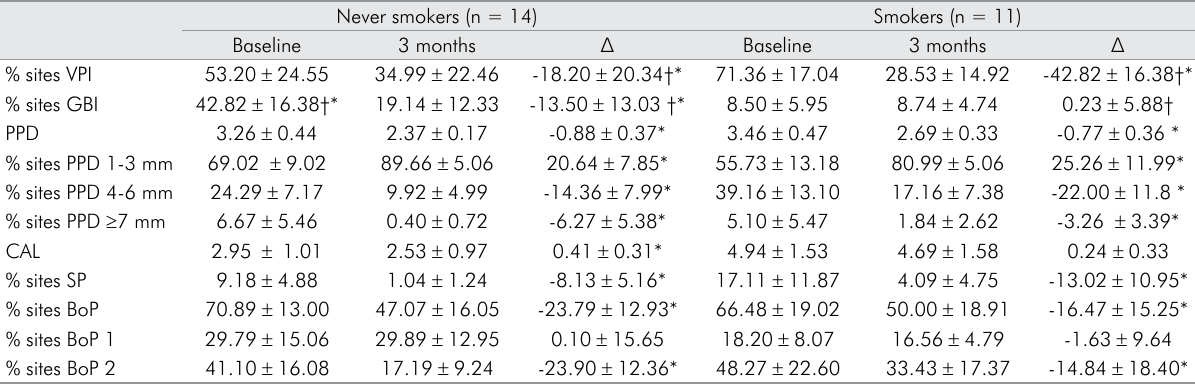
Table 2. Mean ( ± SD) periodontal parameters at baseline and 3 months post-therapy as well as mean changes ( Δ ).